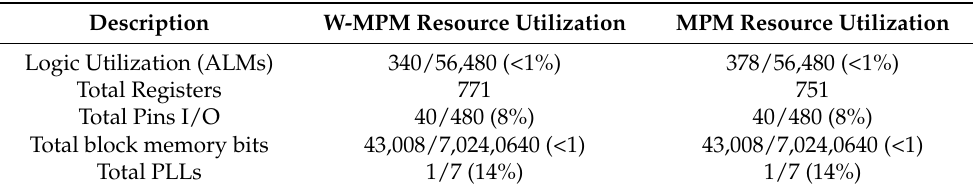
Table 3. Hardware resources occupation in Cyclone V 5CEFAF31I7 FPGA device with comparison for the W-MPM and MPM